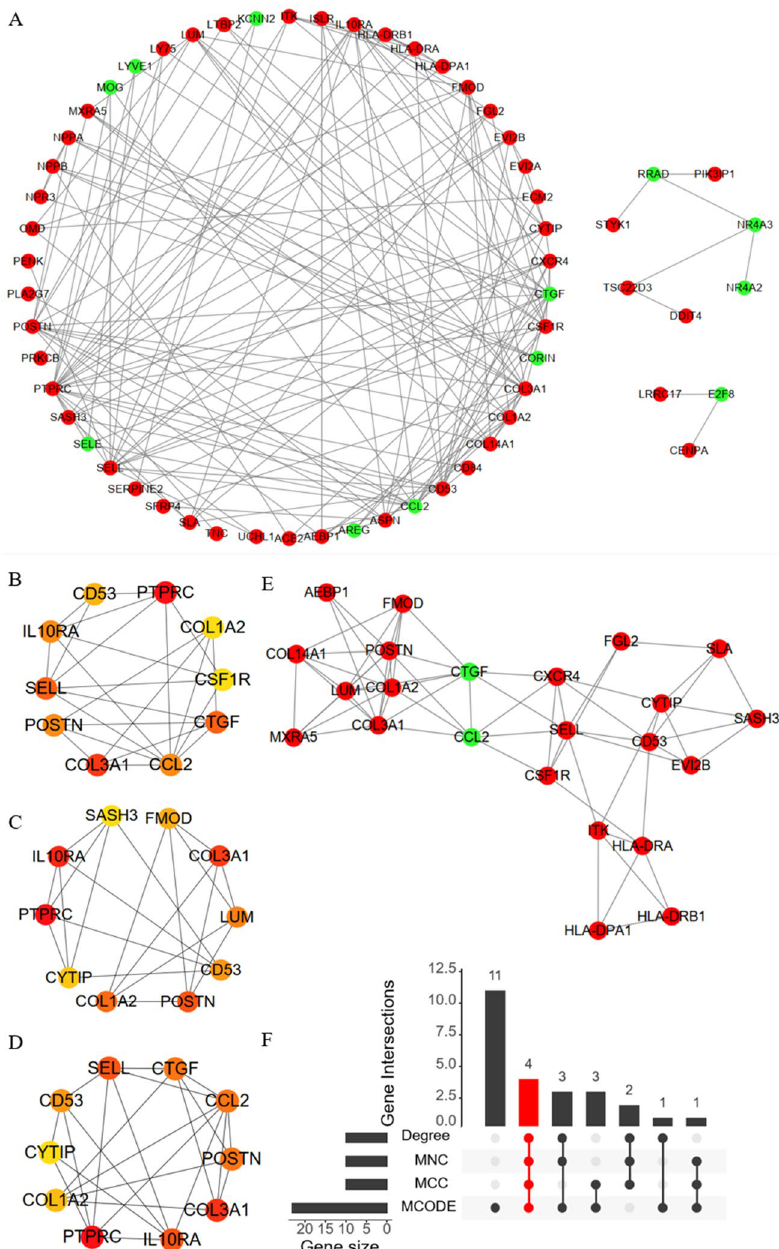
Figure 5. Construction of PPI network and identification of the hub genes in DCM. ( A ) PPI network of DEGs was constructed using STRING; A total of three algorithms from CytoHubba, including ( B ) Degree algorithm, ( C ) MCC algorithm, and ( D ) MNC algorithm, were used for the top ten genes; ( E ) The key module within the PPI network was identified from MCODE; ( F ) The hub genes were identified via the Upset plot. PPI: protein– protein interaction; DEGs: differentially expressed genes; MCC: maximal clique centrality; MNC: maximum neighborhood component. Red color represents up-regulated genes and green color represents down-regulated genes in ( A ) and ( E ); Advanced ranking is represented by a redder color in ( B – D